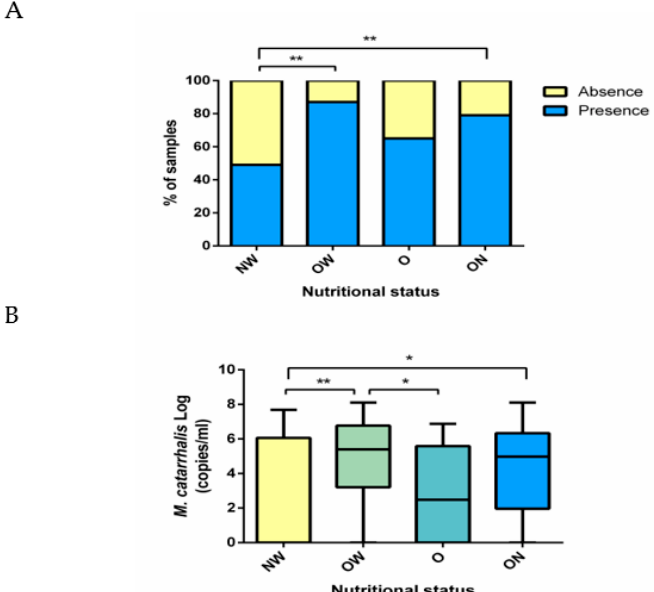
Figure 3. Frequency of M. catarrhalis detection and M. catarrhalis loads according to nutritional status. ( A ) Frequency of M. catarrhalis detection according to nutritional status. Proportions were analyzed with a chi-square test. ( B ) M. catarrhalis loads according to nutritional status. Kruskal–Wallis followed by Dunn’s test with Bonferroni correction were applied to adjust for multiple comparisons ( p = 0.01). NW, normal weight; OW, overweight; O, obese; ON, overnutrition * and ** refer to significant levels at <5% and <1%, respectively. p < 0.05 was considered statistically